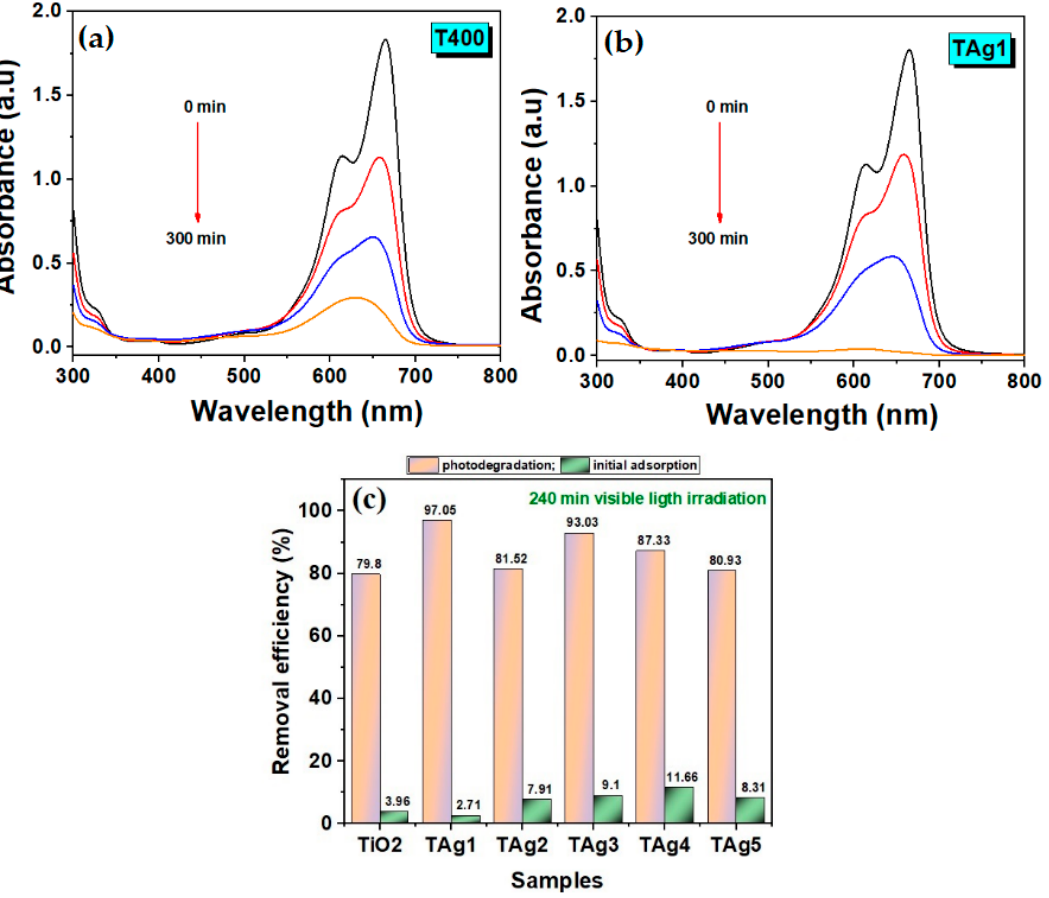
Figure 8. UV-VIS absorption spectra for the degradation of MB dye (10 mg/L) at various irradiation times in the presence of pure TiO 2 ( a ), 0.1% Ag–TiO 2 nanostructured nanofibers ( b ), and ( c ) color removal efficiency obtained for all materials after the end of the